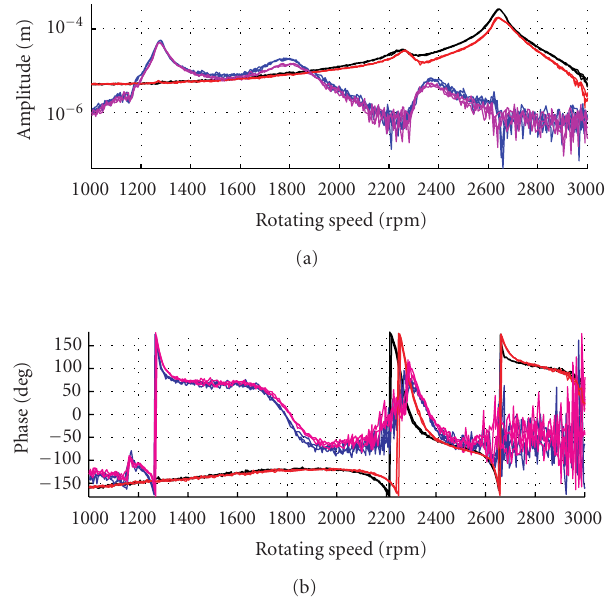
Figure 11: Unbalance responses at the bearing support B1 for run- up and run-down (black line = 1st-order run-ups; red line = 1st- order run-downs; blue line = 2nd-order run-ups; magenta line = 2nd-order